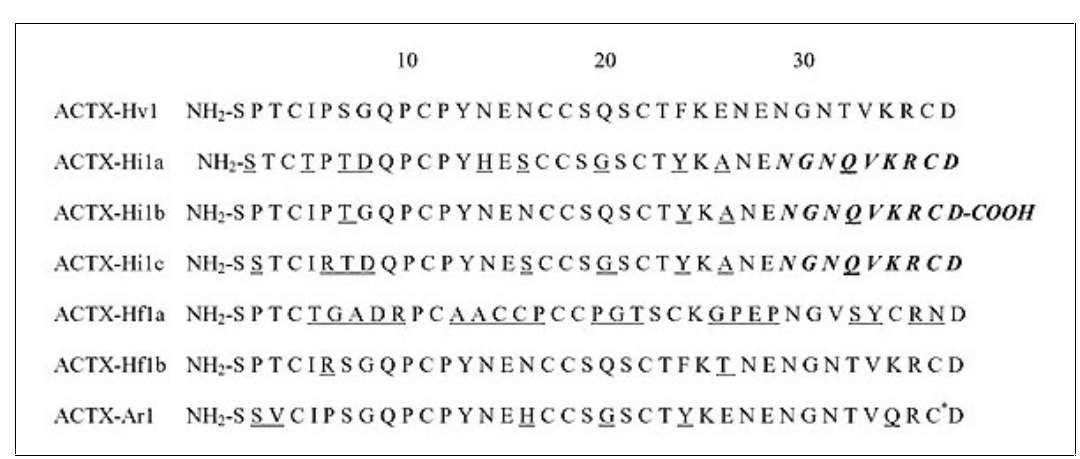
Figure 4: Atracotoxin amino acid sequences aligned, except for atracotoxin-Hf1a, as per Fletcher et al. (8). Homologies are relative to atracotoxin-Hv1. Amino acid residues in the other toxins that differ from those of atracotoxin-Hv1 are underlined. The residues in the sequences of atracotoxins-Hi1a, b and c shown in bold and italics were also isolated and sequenced from the endopeptidase Glu-C digests. The final cysteine residue, marked * , in the sequence of atracotoxin-Ar1 is assumed from sequence homology. The first five such residues in this toxin were identified experimentally as carboxymethyl derivatives.